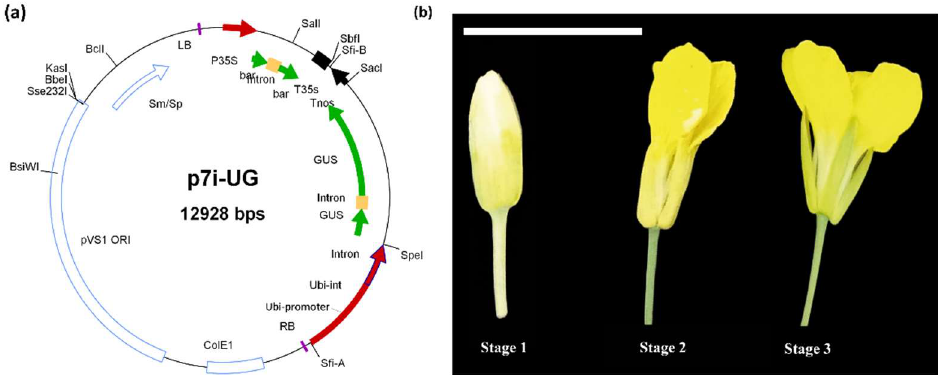
Figure 3. Expression vector and different flower stages used in Agrobacterium -mediated transfor- mation. ( a ) P7i-UG construct harboring GUS reporter gene and Bar gene as a selectable marker, ( b ) flower stages attempted in Agrobacterium -mediated floral-dip transformation (Bar = 1 inch).